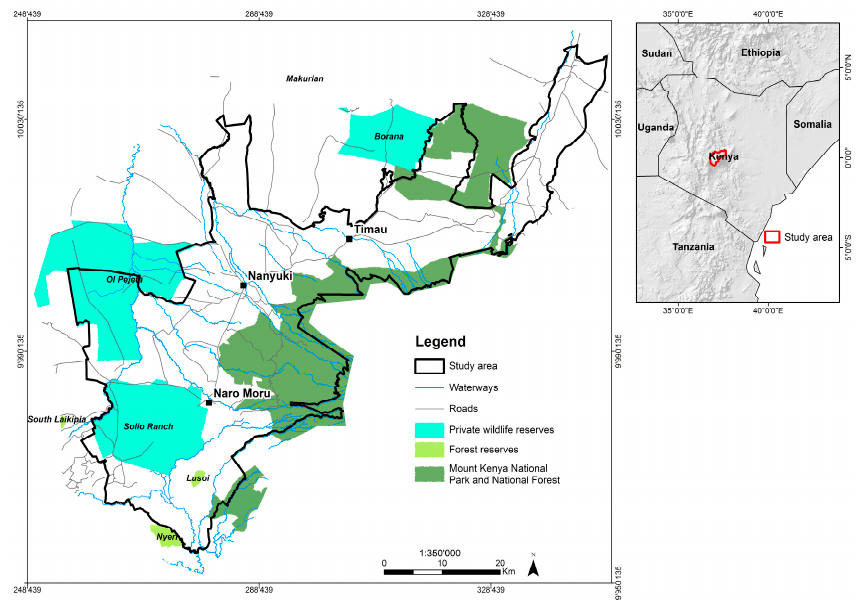
Figure 1. Overview of the study area located in the foothills of Mount Kenya (map projection of detailed study area map: UTM 37S).